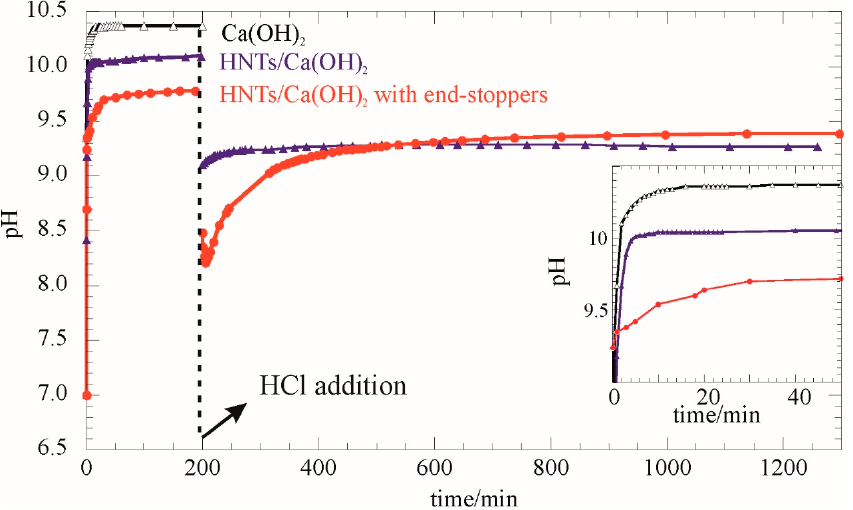
Figure 7. pH measurements in aqueous dispersion before and after HCl solution addition as functions of time. The inset reports an enlargement of the initial